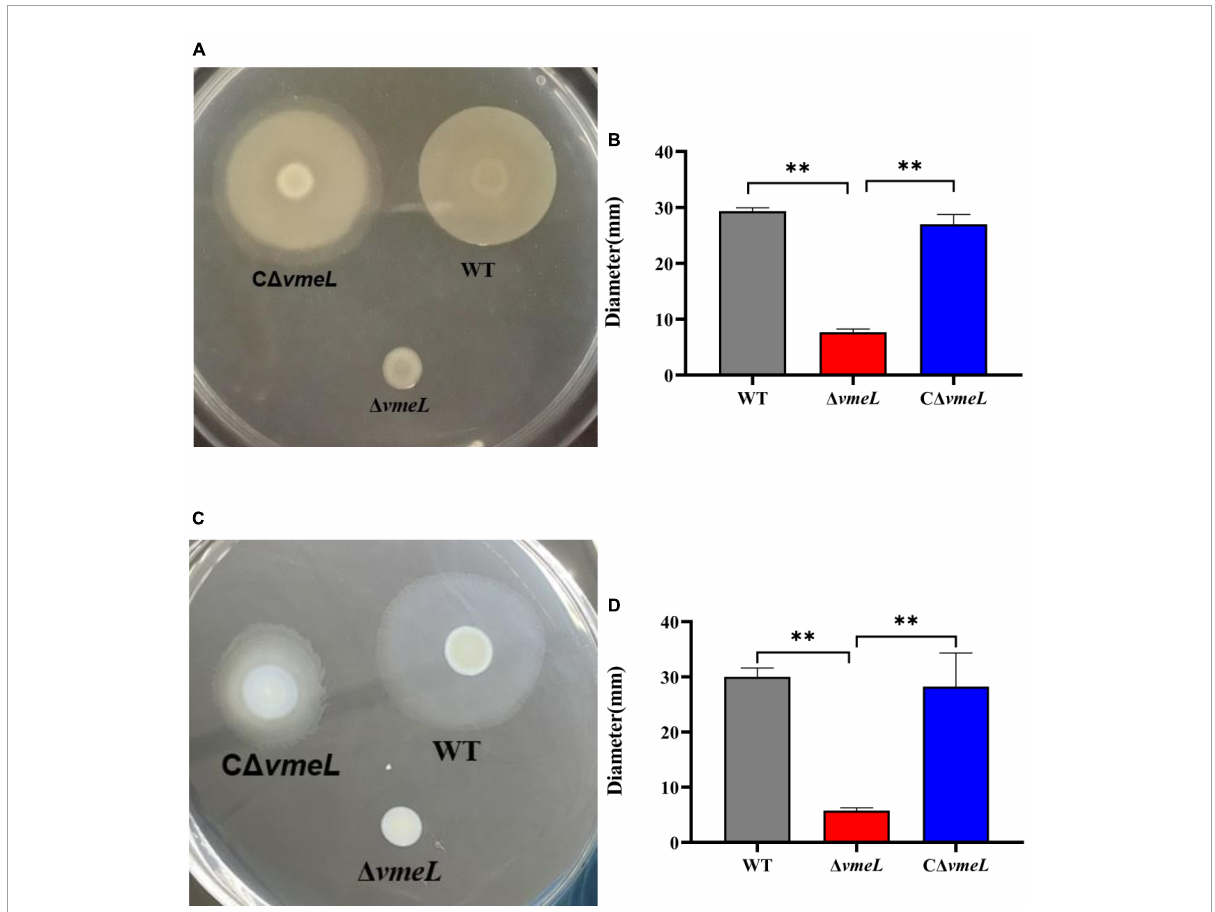
FIGURE2 VmeL is required for surface motility of Vibrio parahaemolyticus . (A) Swarming motility was tested on swarming plates (heart infusion medium with 2% NaCl and 1.5% agar) at 30 ◦ C, and images were taken after 18 h. (C) Swimming motility was tested on swimming plates (Lysogeny broth supplemented with 1% NaCl and 0.3% agar) at 37 ◦ C, and images were taken after 4–5 h. (B,D) Representation of the swarming and swimming separately colony diameters, measured in three independent assays. WT, wild-type; (cid:49) vmeL , vmeL deletion mutant; C (cid:49) vmeL , deletion mutant complemented strain. ∗∗ indicates statistical significance at P < 0.01.